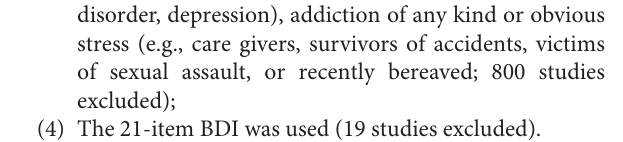
symptoms in individuals aged 13 years and above (Beck et